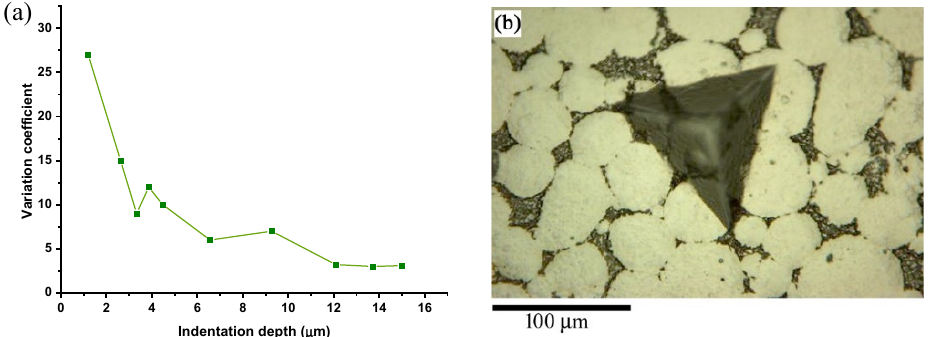
Figure 10. The penetration depth dependence of the variation coefficient δ for the V95\10% SiC MMC ( a ) and a typical image of an indent on the specimens ( b ) at an indenter penetration depth of 15 µm.